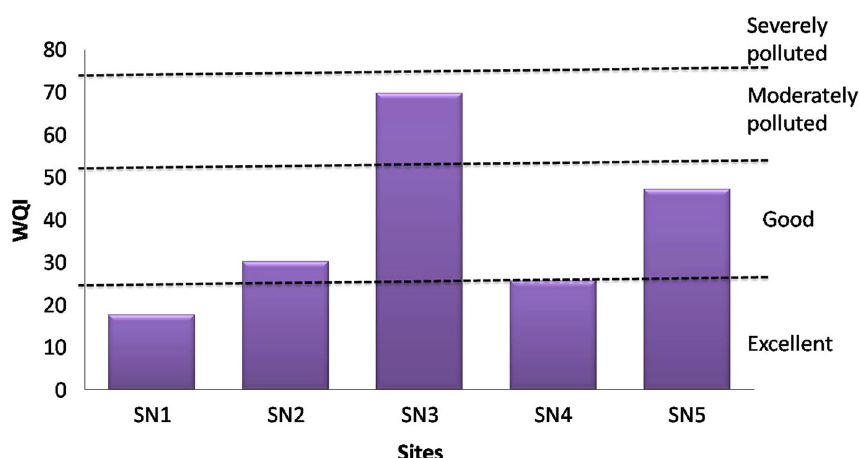
Fig. 4 Graph showing water quality index of different